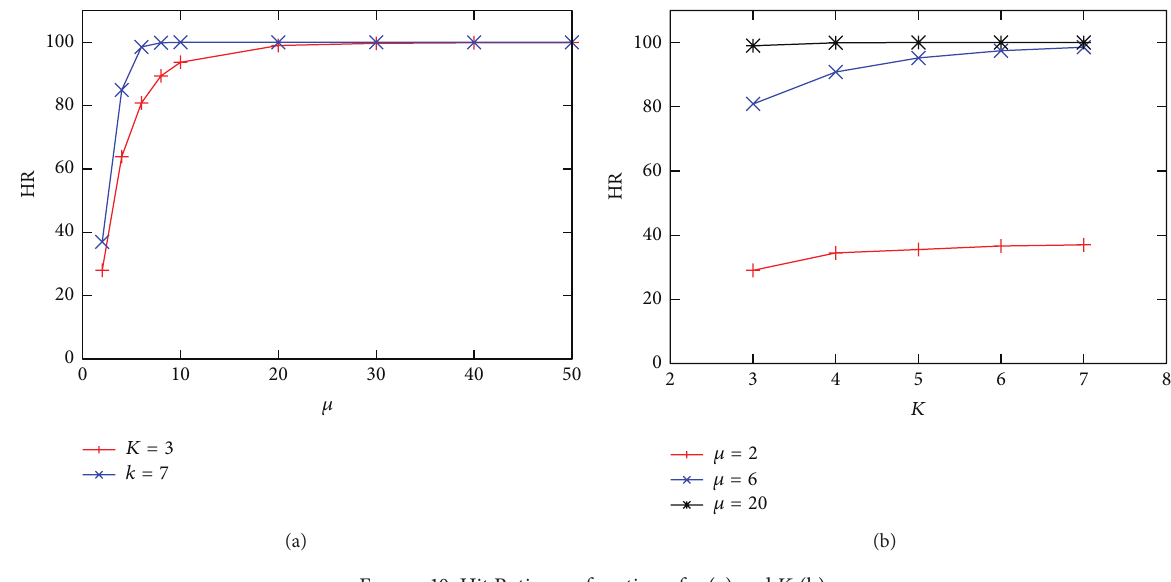
Figure 10: Hit Ratio as a function of 𝜇 (a) and 𝐾